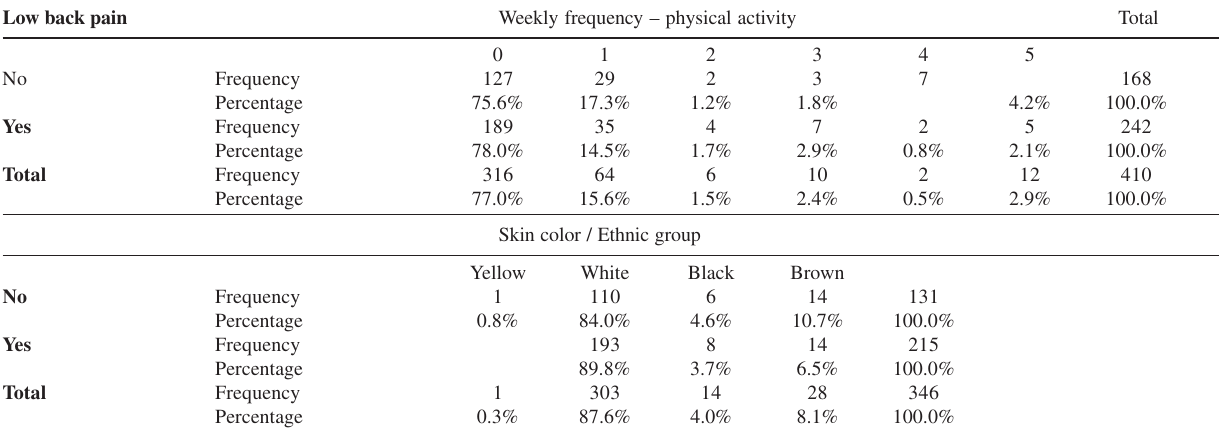
Table 4 - Frequency distribution and percentages of weekly frequency of physical activity practice and ethnic group variables according to the Yes and No categories of low back pain Low back pain